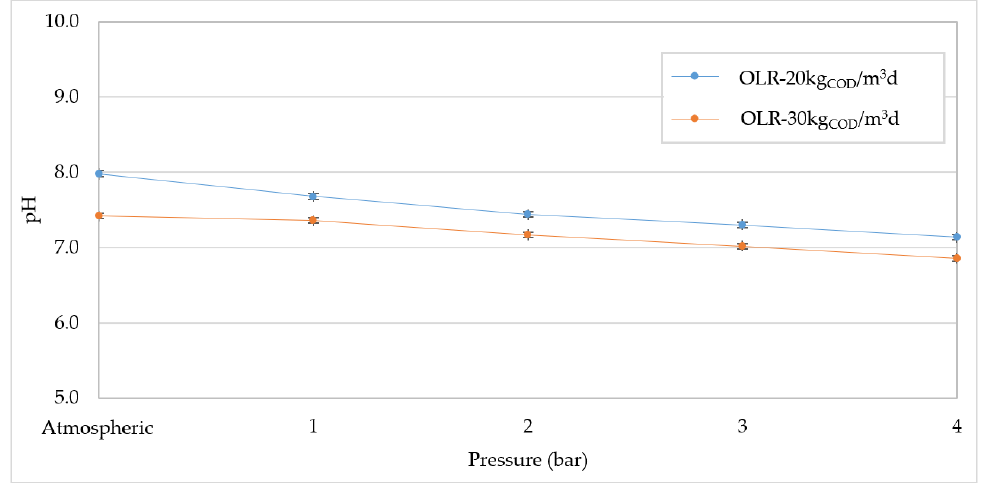
Figure 8. pH values at increasing pressures for organic load rate (OLR) of 20 kg COD /m 3 d and 30 kg COD /m 3 d.